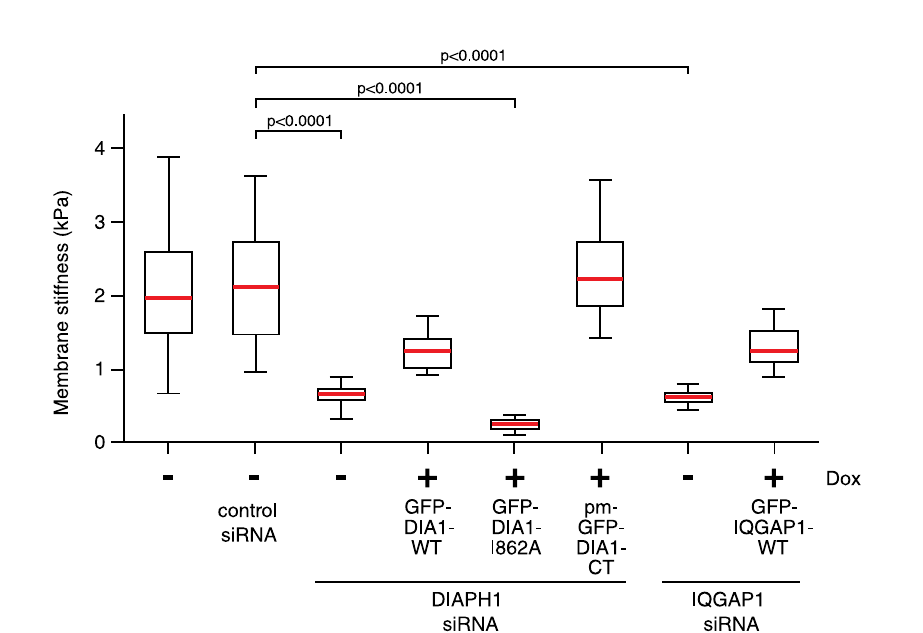
Fig. 2 Cortical γ -actin is required for metaphase cortical stiffness. Young ’ s modulus, measured in kPa, of HeLa cells in metaphase was measured by Atomic Force Microscopy. Actual numerical values and force curves are shown in Supplementary Fig. 3d. p < 0.0001, using nonparametric two-tailed Mann-Whitney t -tests for three experimental repeats. n = 29, 29, 29, 27, 29, 29, 27, or 28 cells examined over three independent experiments (correlated to each condition from the left to the right in the graph). Bars = average, boxes = 25 – 75 percentile, whiskers = extreme. DIA1 = DIAPH1, CT = C-terminus, WT = wildtype, DOX =